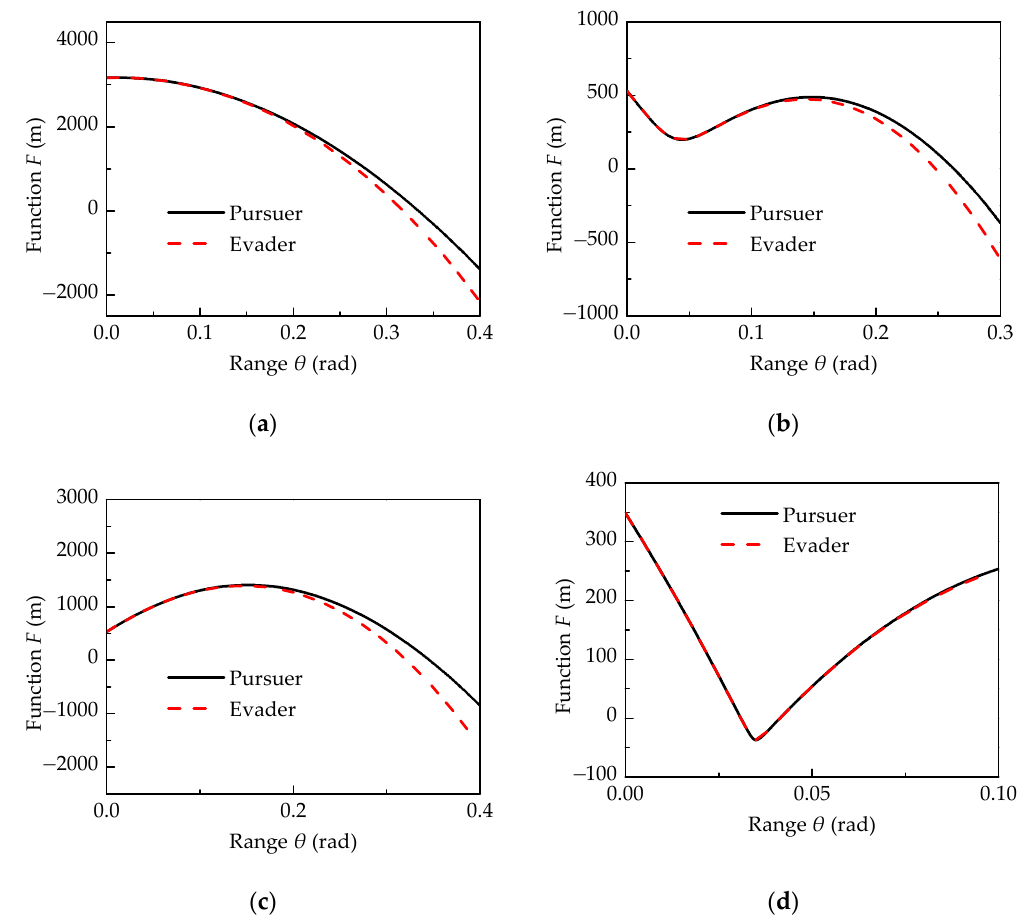
θ Figure 2. The function F change with range Figure 2. The function F change with range θ in ( a ) case 1, ( b ) case 2, ( c ) case 3 and ( d ) case 4. Table 1. Current relative states of different cases. Table 1. Current relative states of different